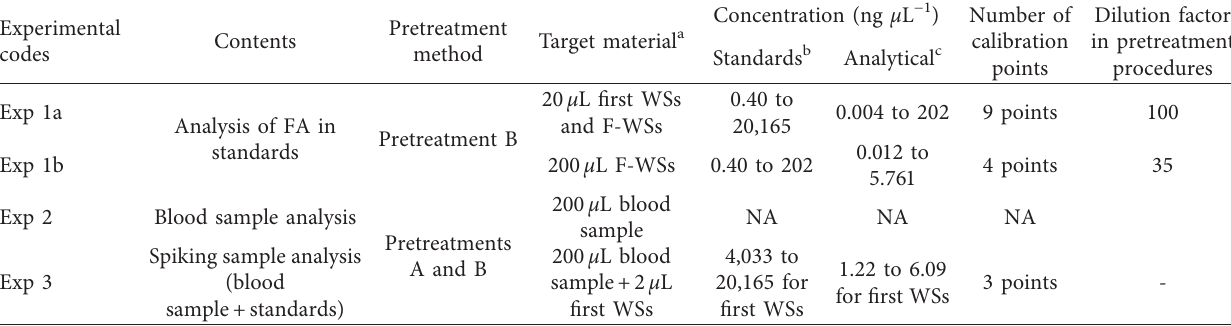
Table 2: Experimental scheme for the development and validation of the pretreatment method for FA analysis in blood samples. Experimental